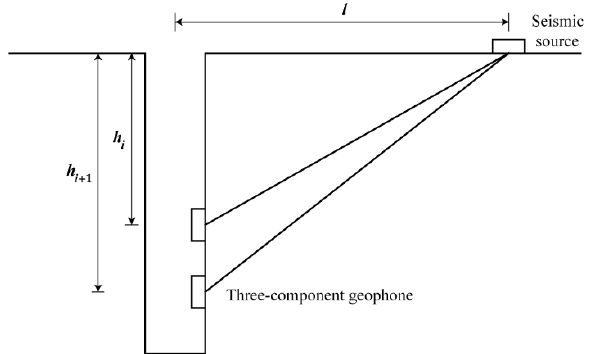
Figure 3. Principle of the single-hole acoustic wave test method.